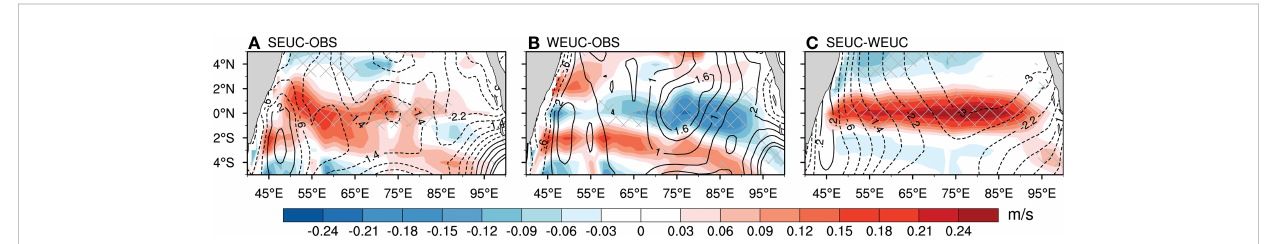
FIGURE 8 Differences of the JFM mean 925-hPa zonal wind biases (contours; units: m/s) and FMA mean subsurface (averaged from 60 to 150 m) zonal current biases (shading; units: m/s) over the EIO between (A) the SEUC group and (B) the WEUC group and the observations. (C) Same as (A) , but for the differences between the SEUC and WEUC groups. Gray crosses indicate the signals that are statistically signi fi cant at the 90% con fi dence level.